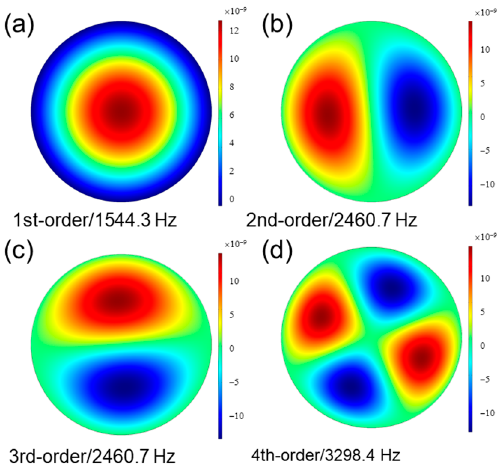
Figure 1. The simulation results of the first four-order resonant frequencies.